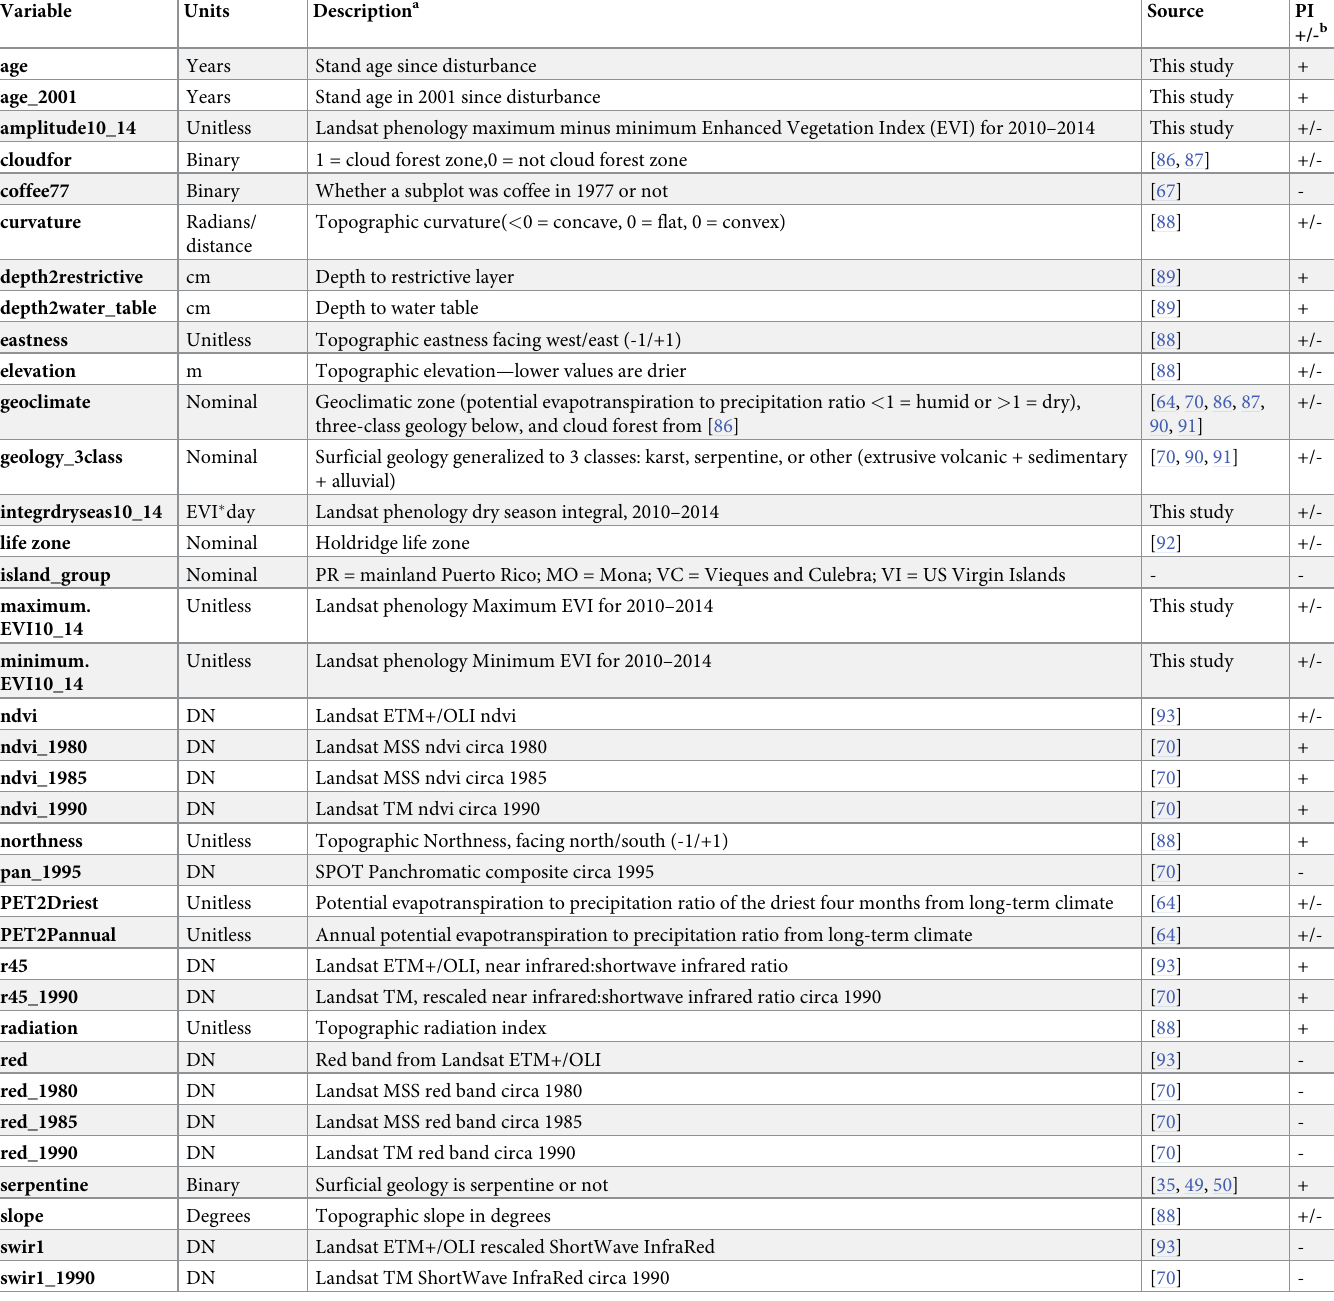
Table 3. Potential spatial predictor variables may relate to shade, moisture, nutrients, or disturbance.